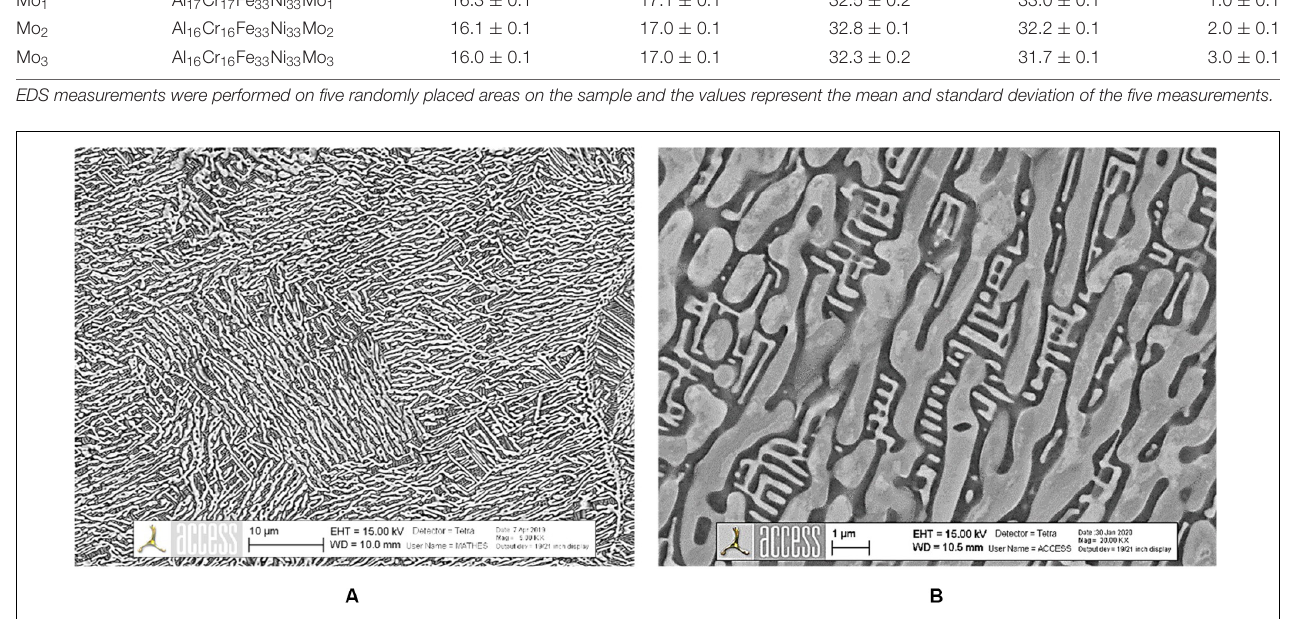
FIGURE 1 | SEM-BSE micrographs of the as-cast microstructure in sample Mo 2 (A) displays a low magnifcation overview while (B) shows the ultrafine vermicular duplex structure with the FCC phase (bright) closely entangled with the spinodal decomposed BCC phase